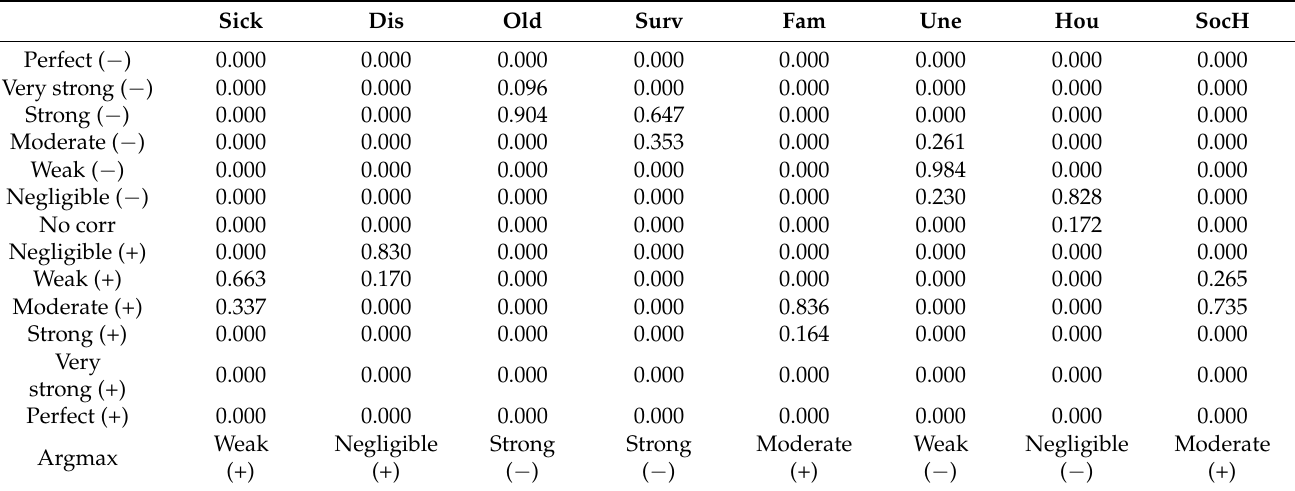
Table 14a. Value of the compatibility indexes (7b) of the correlations between DF and the proportion that each kind of social expense suppose in overall SE and the labels of the linguistic variable “correlation coefficient”